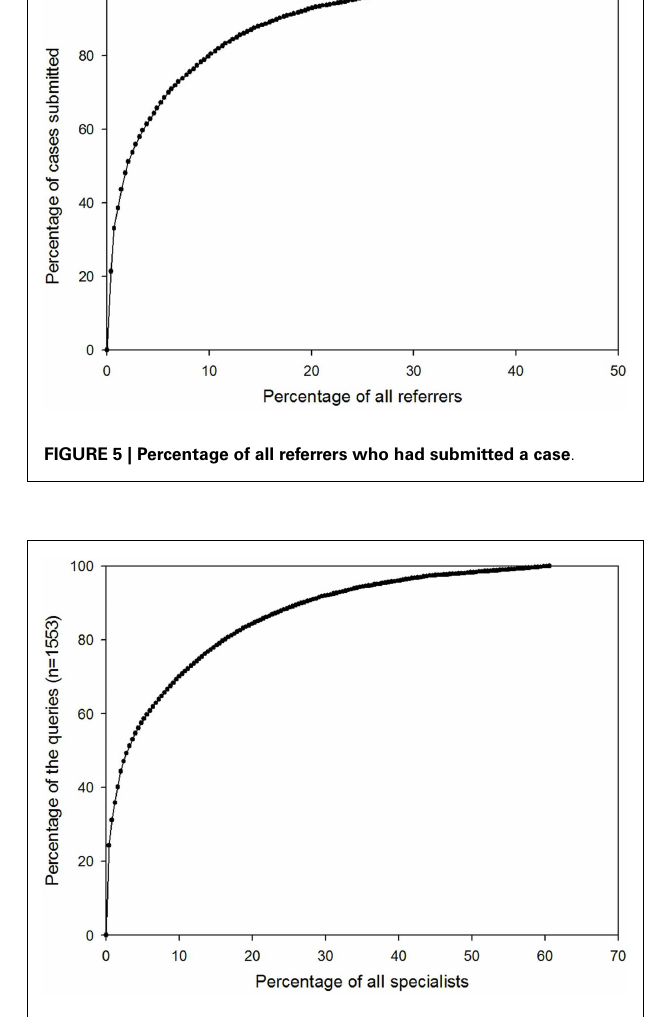
FIGURE 6 | Percentage of all specialists who had been sent a query